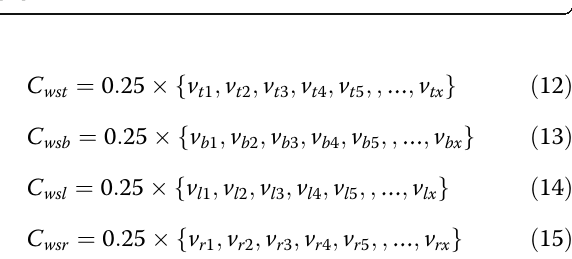
Fig. 10 Sample images associated with image benchmark of the Corel-1.5K